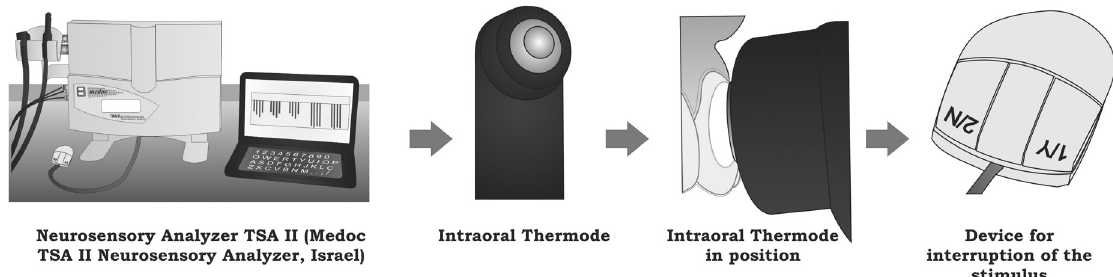
Figure 5- Scheme of the tooth neurosensory analysis using the equipment TSA